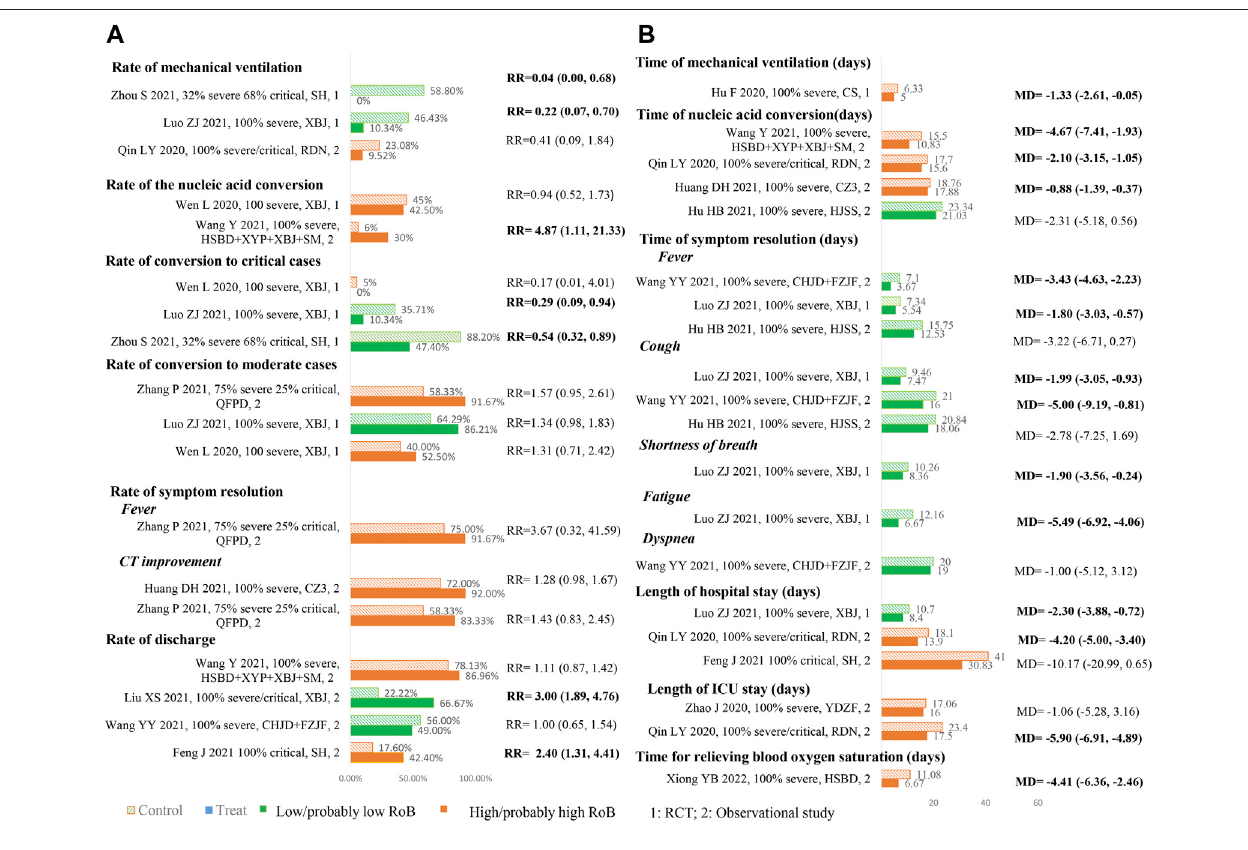
FIGURE 5 | Summary of dichotomous (A) and continuous (B) .